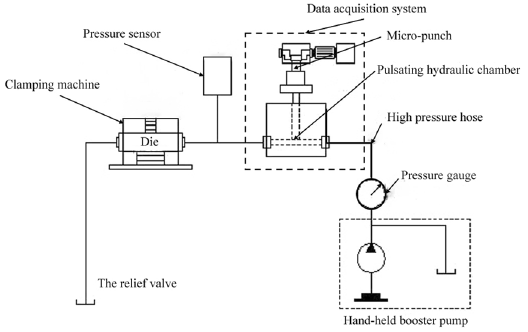
Figure 3 High-pressure forming mold in a rectangular